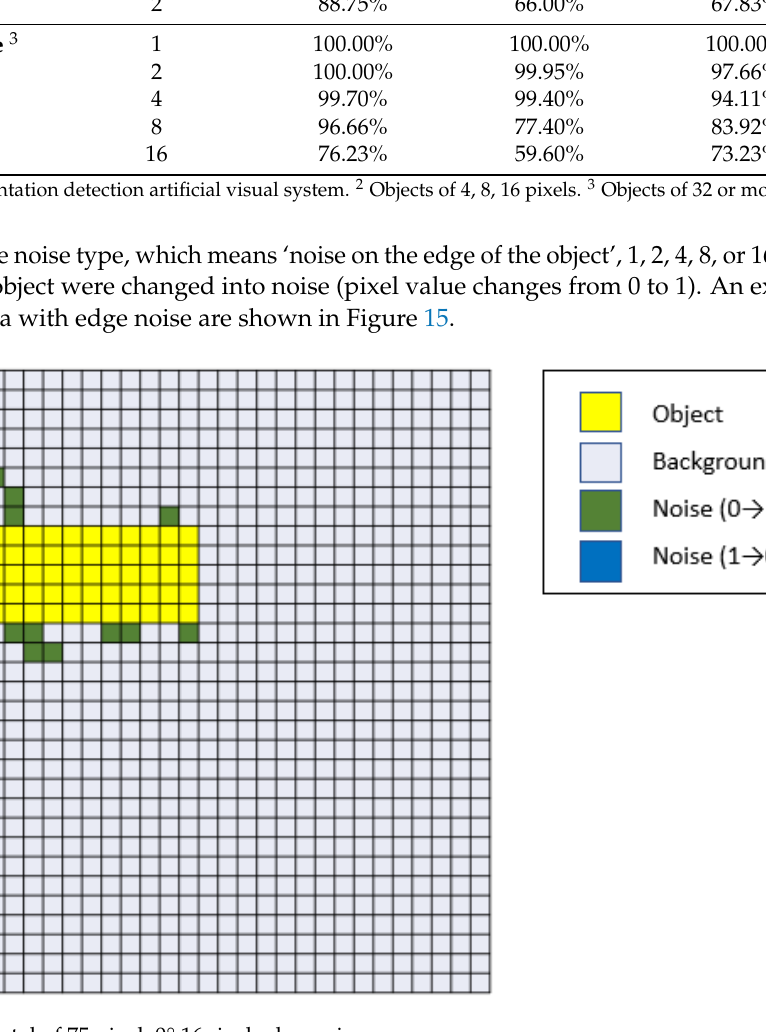
Figure 15. A total of 75 pixel, 0° 16pixel edge